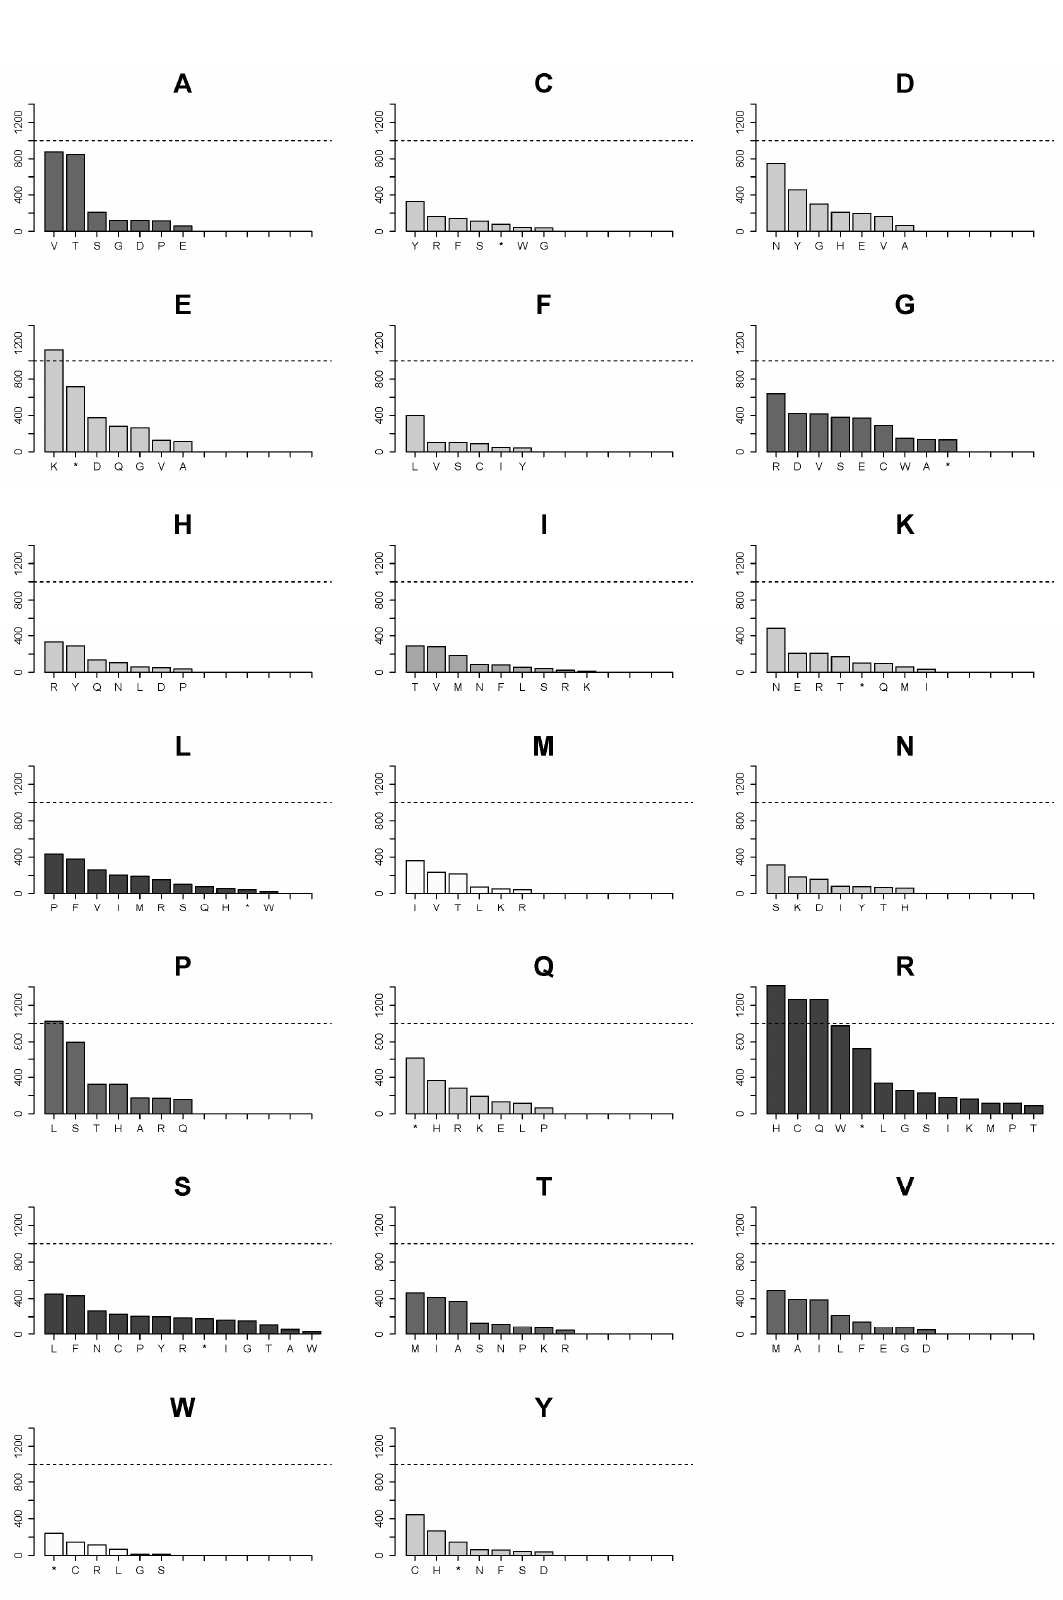
Figure 4. Landscape of ways of loss of each amino acid in individual substitutions in mutations in the CCLE database. The dotted horizontal line marks 1000 substitution events. The bars in each graph are colored according to the number of codons for a respective amino acid similarly to the previous graphs. The letter in the title of each graph denotes the amino acid that is lost in mutations.